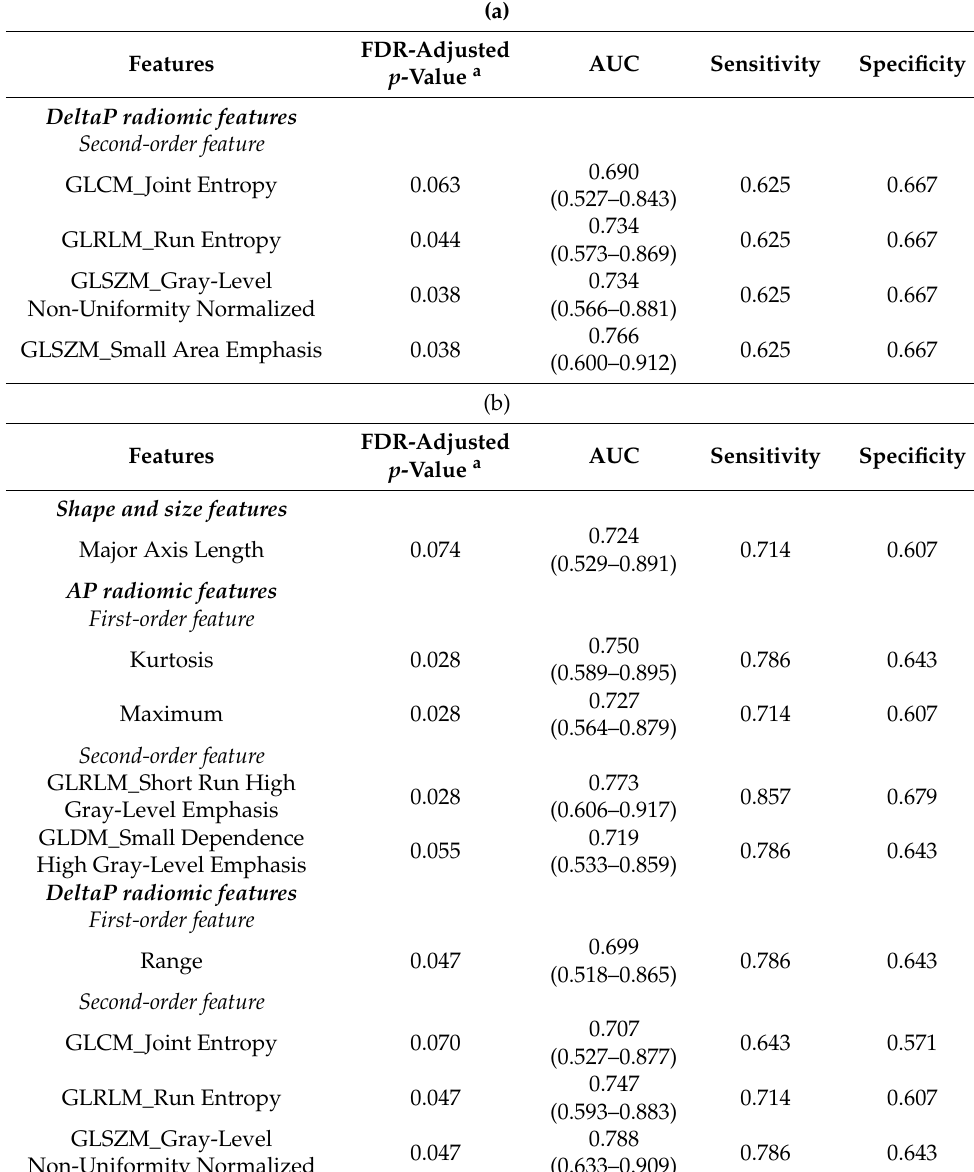
Table 4. A list of independent predictors that demonstrated significant clinical association with the (a) 3-month and (b) 6-month response rate assessment. Statistical significance is indicated by false discovery rate (FDR)-adjusted p -value, after applying the Benjamini–Hochberg (BH) procedure for multiple test corrections. AUC, sensitivity, specificity, and p -value obtained from logistic regression for each of these independent significant predictors are also reported. The superscript a denotes FDR-adjusted p -values obtained after applying the BH